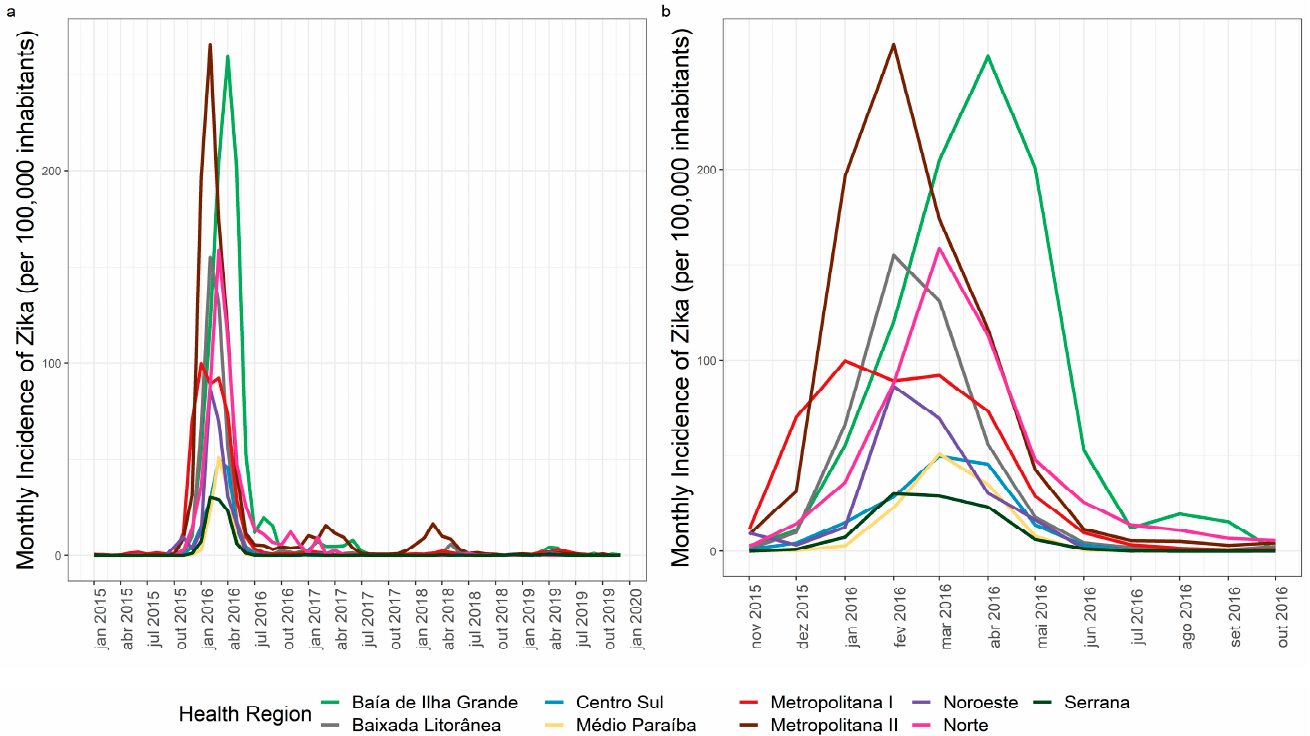
Figure 8. ( a ) Zika by month/year of symptom onset in Rio de Janeiro state, 2015–2019. ( b ) Zika by month/year of symptom onset in Rio de Janeiro state, November 2015–October 2016.